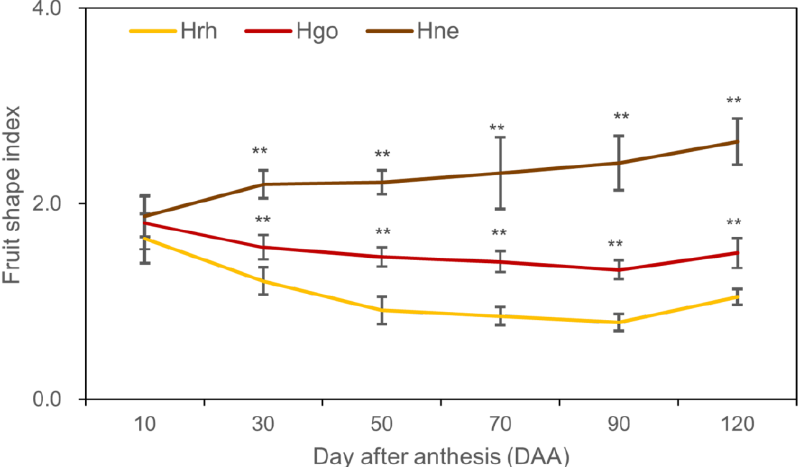
Figure 4. Fruit shape index of three species of Hippophae. Hrh H. rhamnoides ssp. sinensis ; Hgo H. goniocarpa ; Hne H. neurocarpa. Error bars represent the standard deviation (SD). “**” indicates significant differences ( p < 0.01) among three species of Hippophae at the same period. (n = 50 fruits).